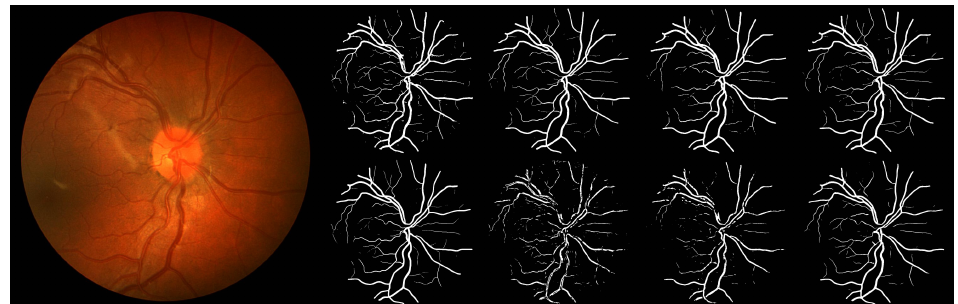
Figure 5. An example of a color fundus image and corresponding eight segmentation masks produced by eight CNN models. From left to right, the masks are generated by DBUNet, RVSGAN, UNet, SA-UNet (top row), LadderNet, IterNet-UNI, IterNet, and ESWANet (bottom